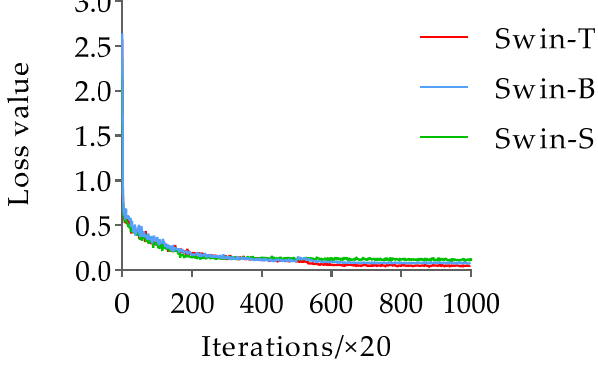
Figure 8. The loss value changes with the number of iterations.